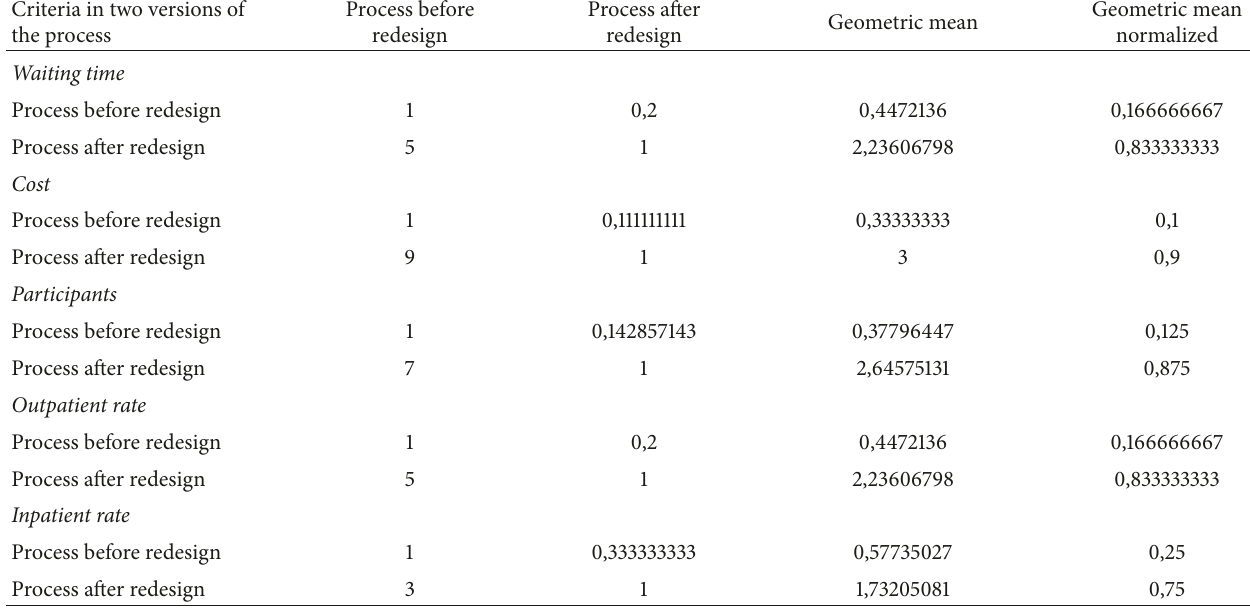
Table 4: AHP: preferences toward both versions of the care process for each one of the four criteria. Criteria in two versions of